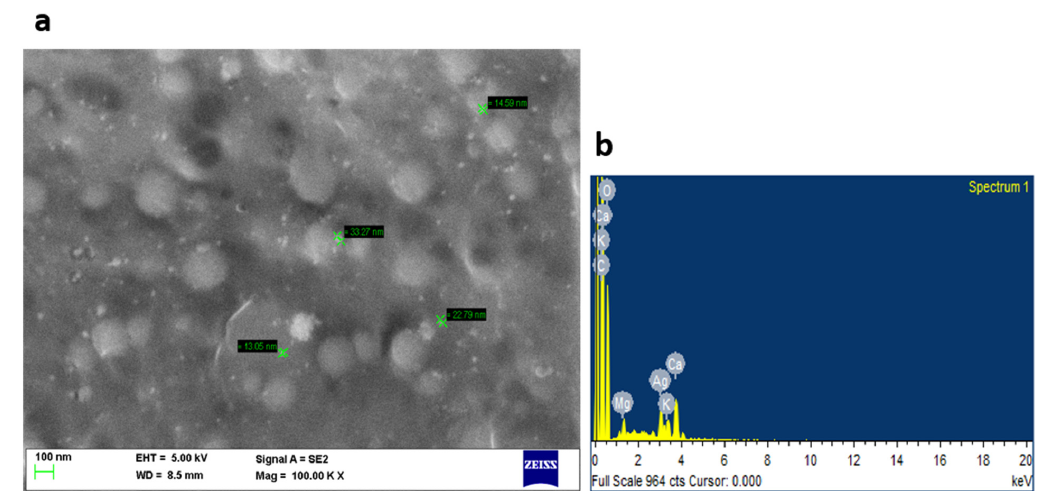
Figure 3. ( a ) SEM analysis, ( b ) EDX analysis for the synthesized silver nanoparticles.